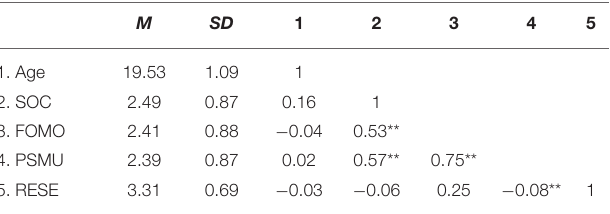
TABLE 1 | Descriptive statistics and correlation matrix for the main variables.